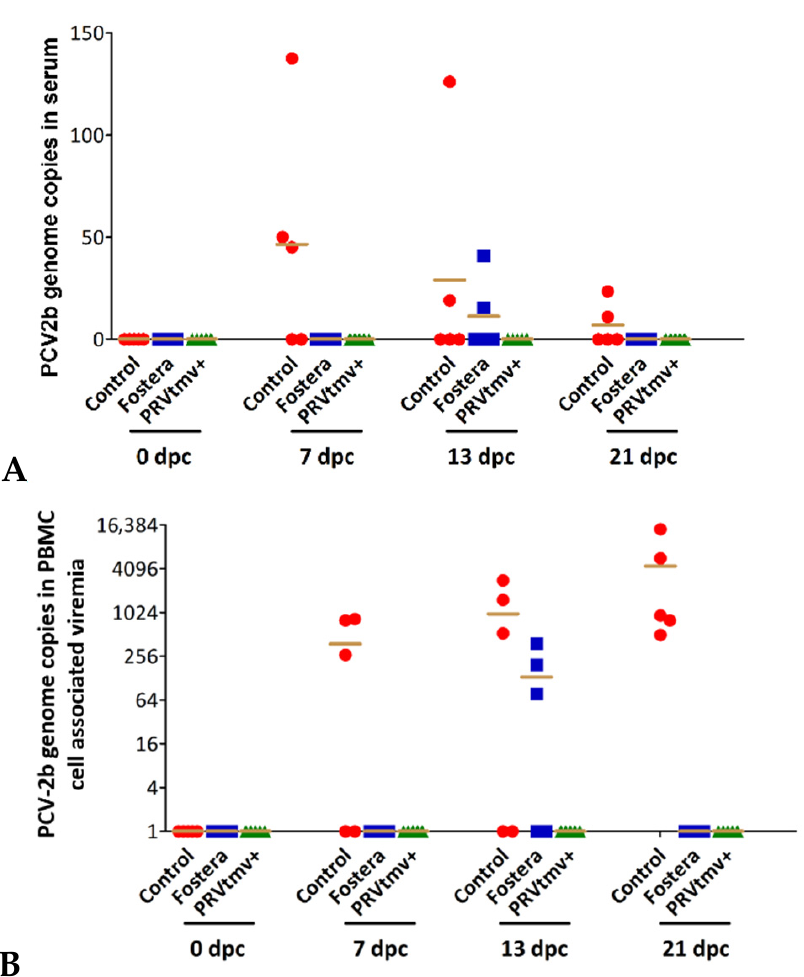
Figure 16. PCV2b in serum (cell-free) and PBMC (cell-associated viremia) in control and vaccinated pigs following the challenge was assessed by qPCR. DNA was isolated from serum and PBMC, and PCV2b qPCR was performed as described. PCV2b genome copy numbers were calculated according to CT-values of a standard curve. ( A ) Shown is the mean copy numbers of PCV2b genome in serum (100 ng of DNA) and ( B ) PBMC (normalized to 10 7 cells) of two independent qPCR analysis of each animal from three vaccination group on 0, 13, 17, and 21 dpc. The dot plot graph represents mean + individual values in each group ( n = 5). dpc—days